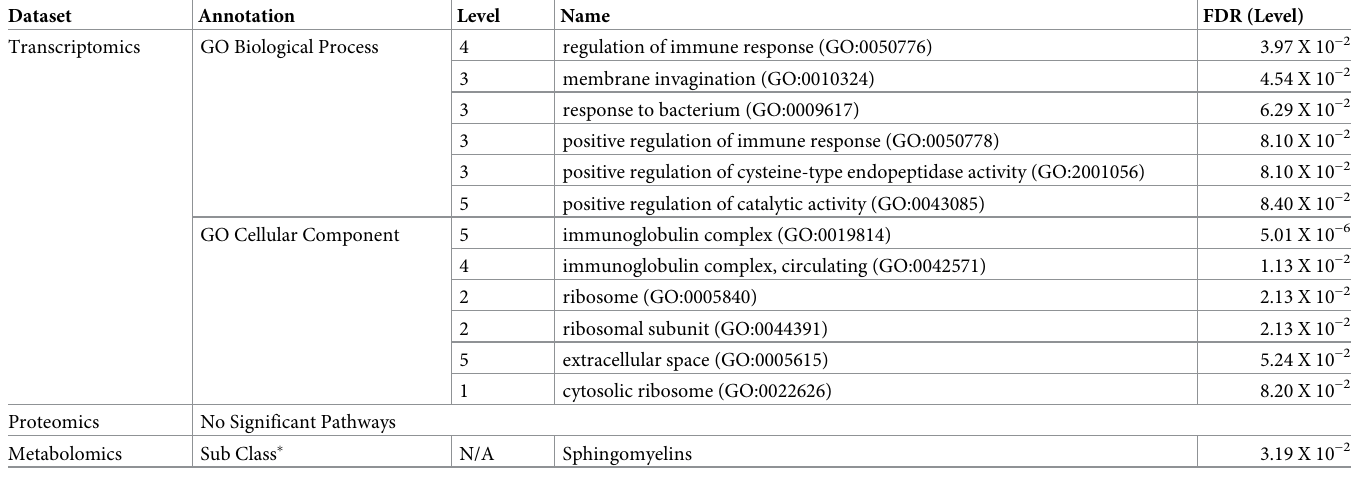
Table 5. Top enrichment pathways from multiple annotation sources. For annotations with a defined hierarchy (gene ontology: GO), p-values were adjusted per-level of the hierarchy (FDR < 0.10). Levels begin from 1, the lowest level of the hierarchy, and increase to the top level, number of levels vary by annotation database.